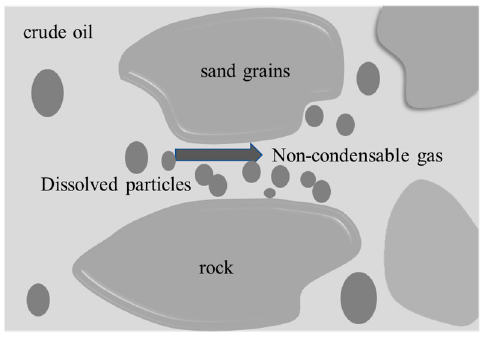
Figure 7. Non-condensable gas displacement process.